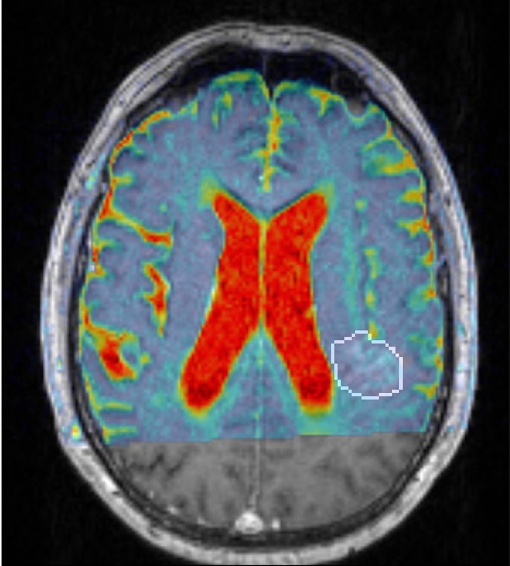
Figure 3. The effect of ROI uncertainties to the texture features. The delineated glioma in a slice near the left lateral ventricle in a 73 year old male, from which the variations in the texture features were calculated in Table 1. The colormap shows the ADC map, fused on the T1-weighted contrast enhanced MPRAGE. An expansion or a shift by one voxel can include CSF in the ROI, which will increase the minimum and maximum values in the ROI, and will have an effect on the resulting texture features. The manual quantization method is less sensitive to this shift.